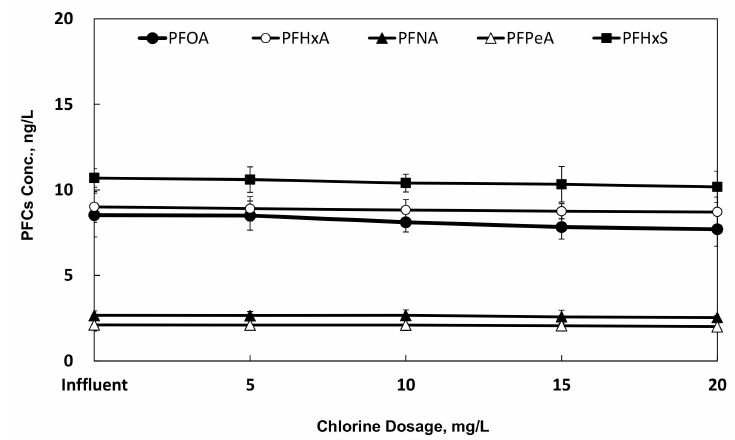
Figure 5. Variations in PFCs concentration with di ff erent chlorine